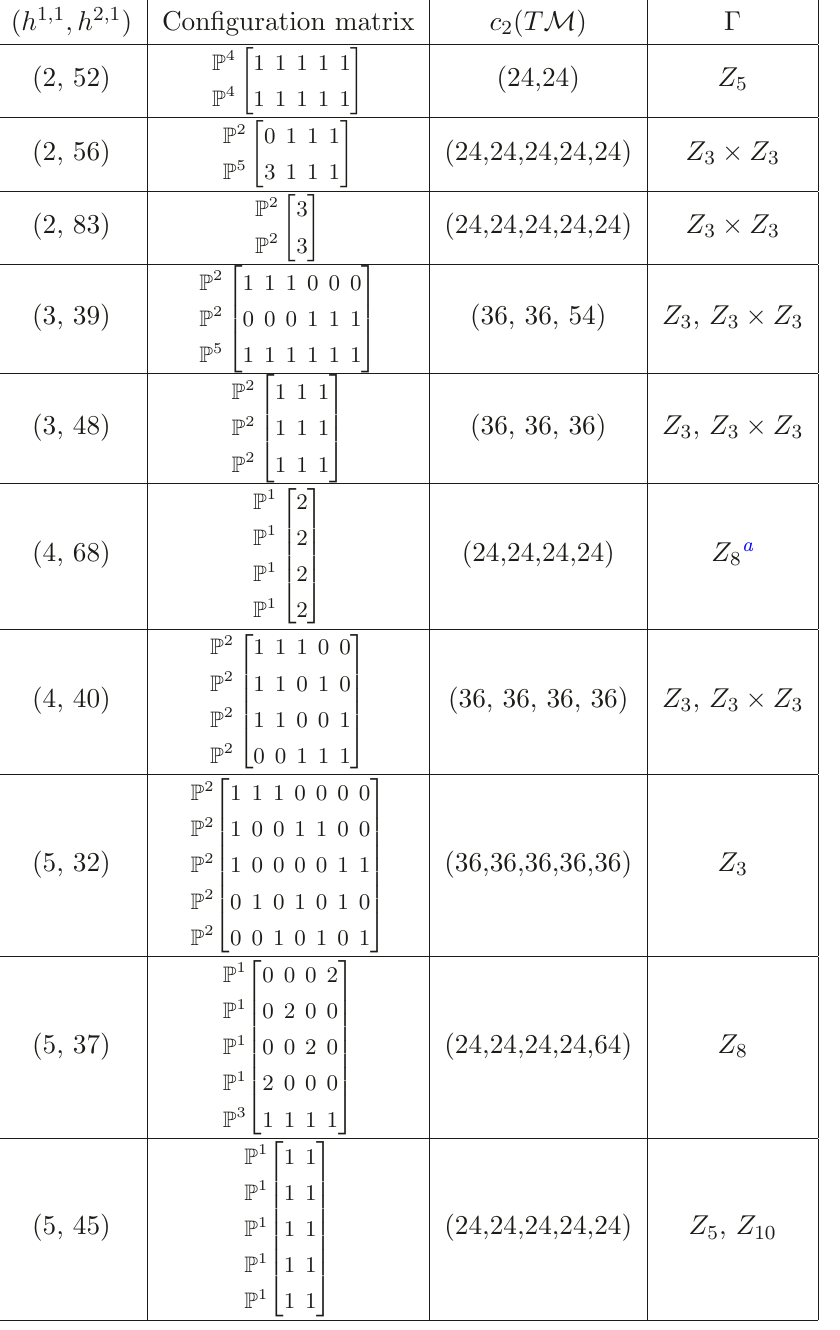
Table 7 . List of favorable CICYs to be applicable for the Pati-Salam